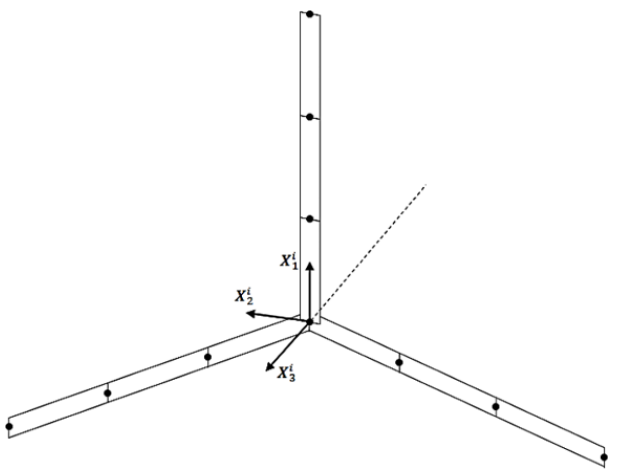
Figure A1. Finite element beam representation of the wind turbine